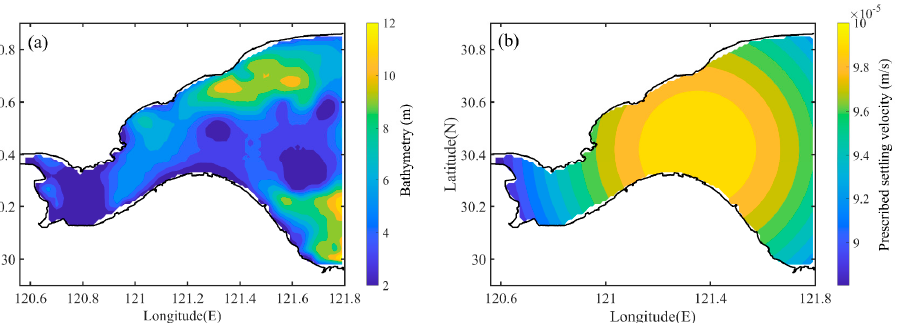
Figure 2. ( a ) Study area and bathymetry of the Hangzhou Bay, and ( b ) Spatial distribution of the prescribed settling velocity in twin experiments.